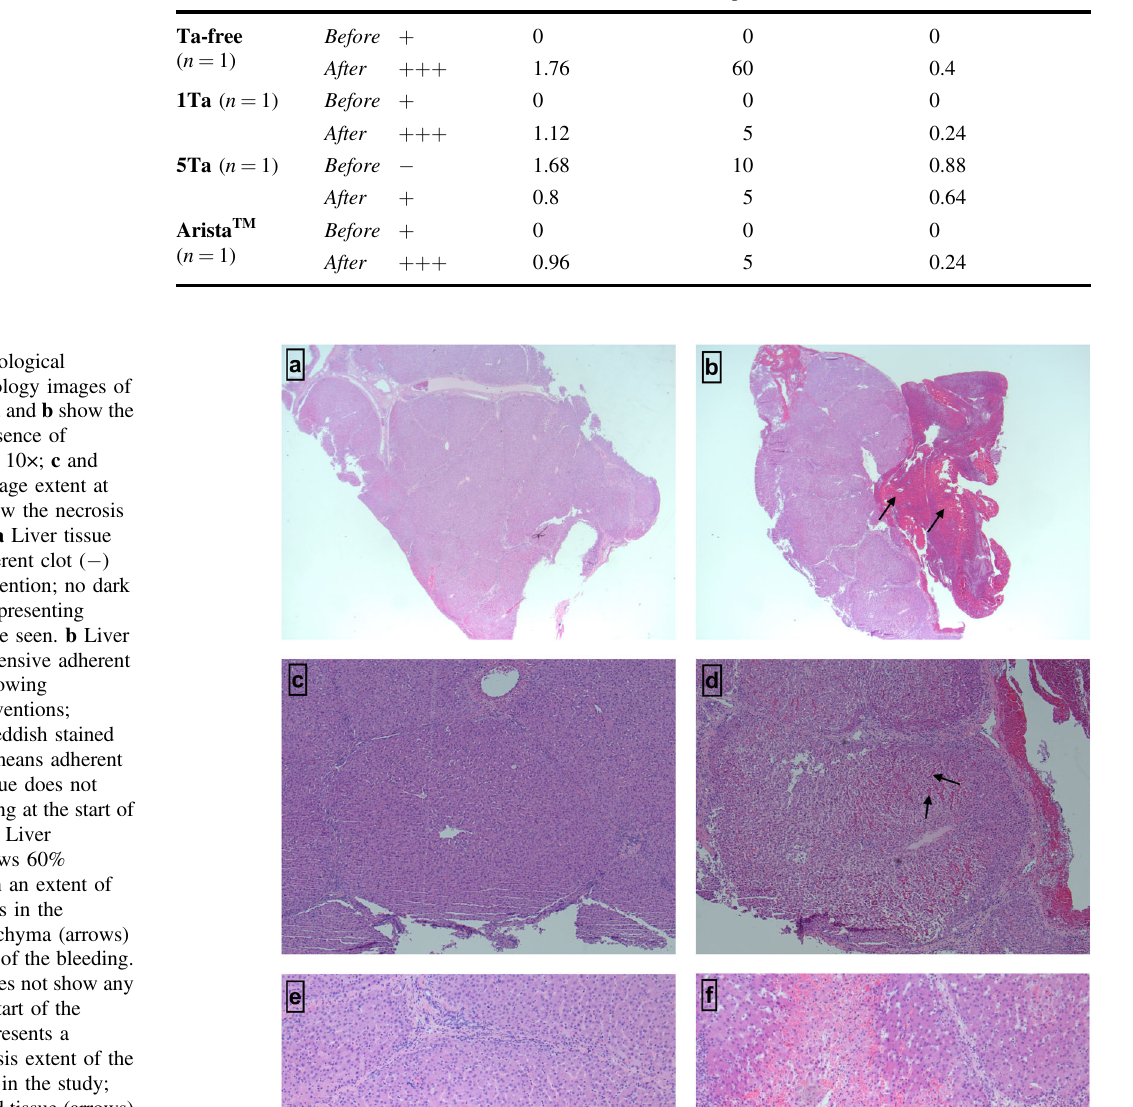
Adherent clot Hemorrhage extent (mm)